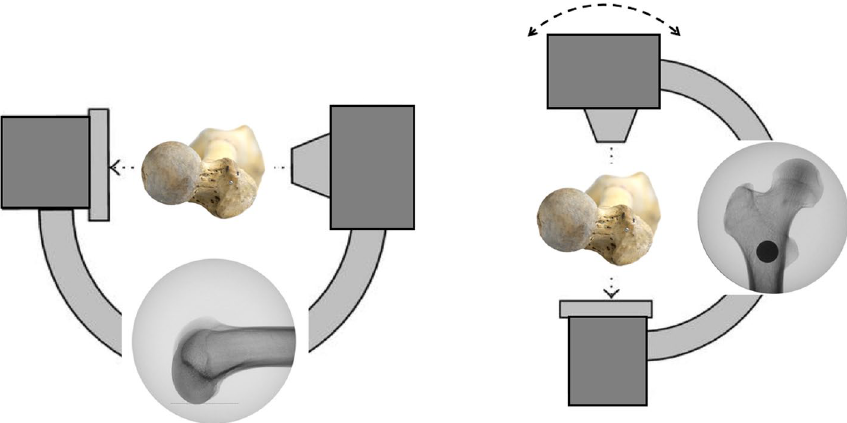
Figure 2. Positioning of the femur and c-arm. Lateral position of the c-arm to determine the neutral position of the femur with perfectly overlapping femoral condyles. The c-arm was moved proximally and into a vertical projection. It was then gradually rotated while obtaining images in 5° intervals from 30° internal rotation to 30° external rotation.